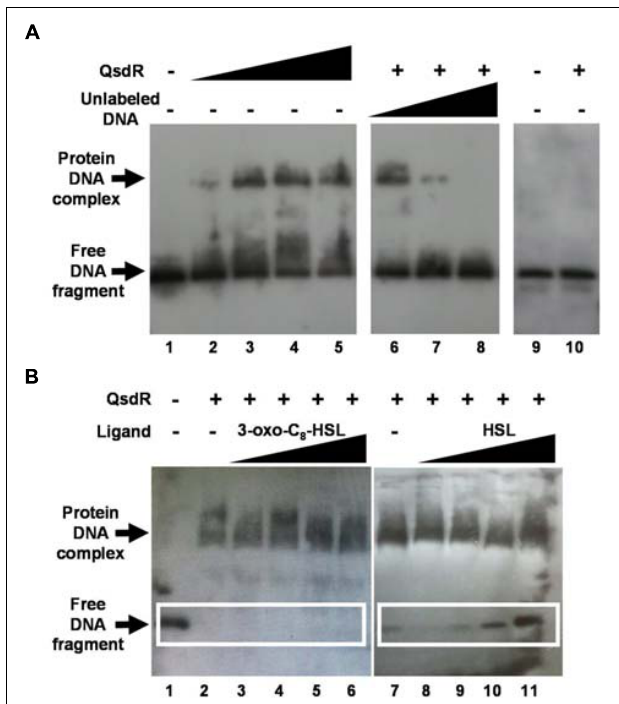
FIGURE 6 | Detection of a QsdR–DNA complex by EMSA using biotin labeled qsdR qsdA intergenic DNA fragment. (A) Binding of QsdR to 0.4 ng of the qsdR qsdA intergenic DNA fragment with increasing amounts of His-tagged QsdR. Lane 1: biotin labeled fragment in the absence of protein ( − ); lanes 2–5: 0.3, 1, 2, and 3 µ g, respectively, of the purified His-tagged QsdR protein; lanes 6–8: 0.4, 0.8, and 4 ng, respectively, of the unlabeled competitor qsdR qsdA intergenic DNA fragment with 2 µ g of the purified QsdR protein ( + ); lanes 9–10: EMSA performed with 0.4 ng of a biotin labeled DNA internal fragment of qsdA gene, used as negative control, in the absence ( − ) or in the presence ( + ) of 2 µ g of the purified QsdR protein. (B) Effect of ligands on the QsdR binding activity. EMSA was performed under the same conditions as described in panel (A) and without (lanes 1, 2, and 7) or with increasing amounts of 3-oxo-C 8 -HSL (lanes 3–6) or HSL (lanes 8–11) molecules by adding a ligand/QsdR molecules ratio increasing from 0.1 to 100 to the reaction binding. The data shown are representative pictures of three independent experiments. Symbols + and − mean the presence or absence of the corresponding molecule,